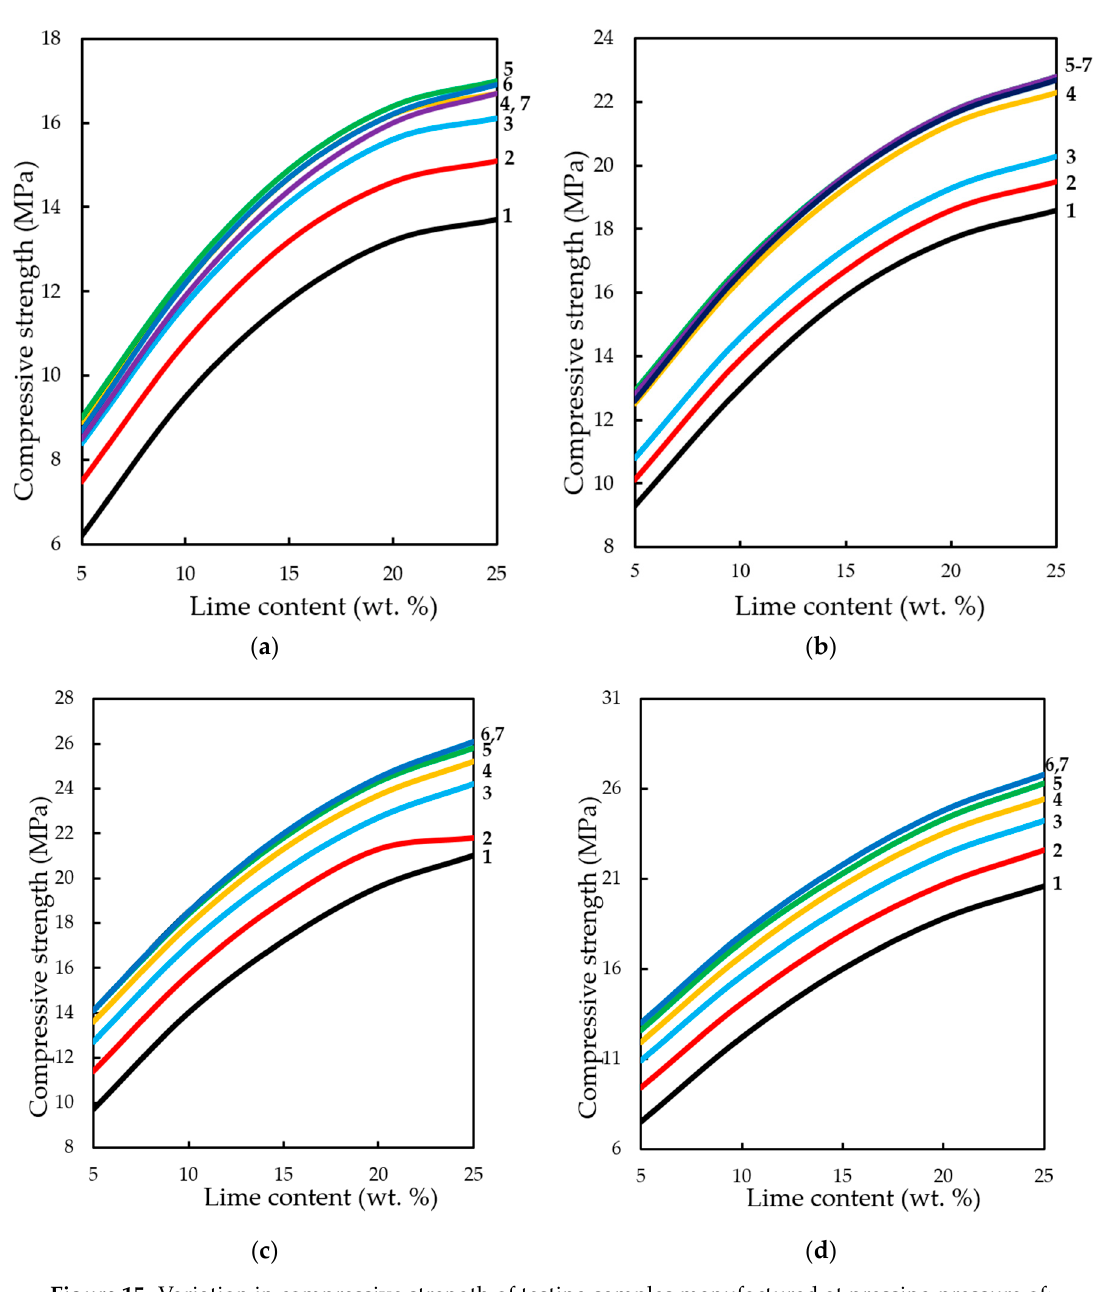
Figure 15. Variation in compressive strength of testing samples manufactured at pressing pressure of: ( a ) 10; ( b ) 20; ( c ) 30; ( d ) 40 MPa. Samples carbonated by dynamic method after five cycles of carbonation, depending on the content of Ca(OH) 2 and concentration of СО 2 , %: 1— 10; 2— 20; 3 —30; 4— 40; 5 —50; 6 —60; 7 —65.